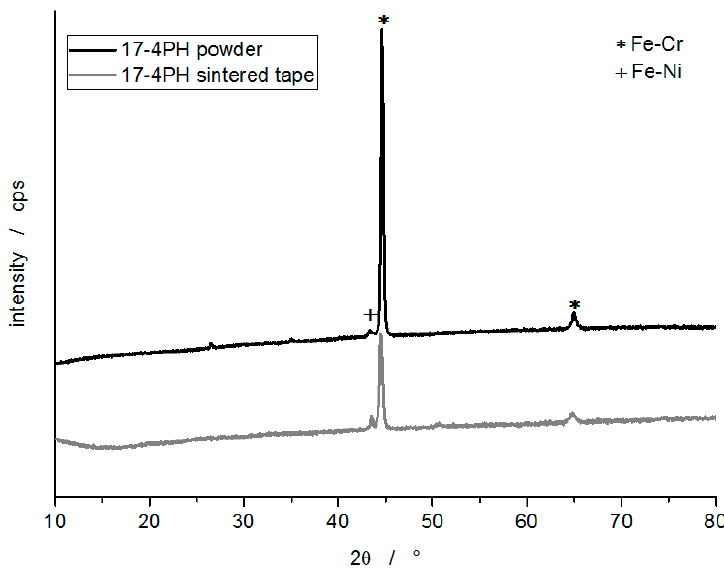
Figure 2. XRD analysis of 17-4PH stainless steel powder.